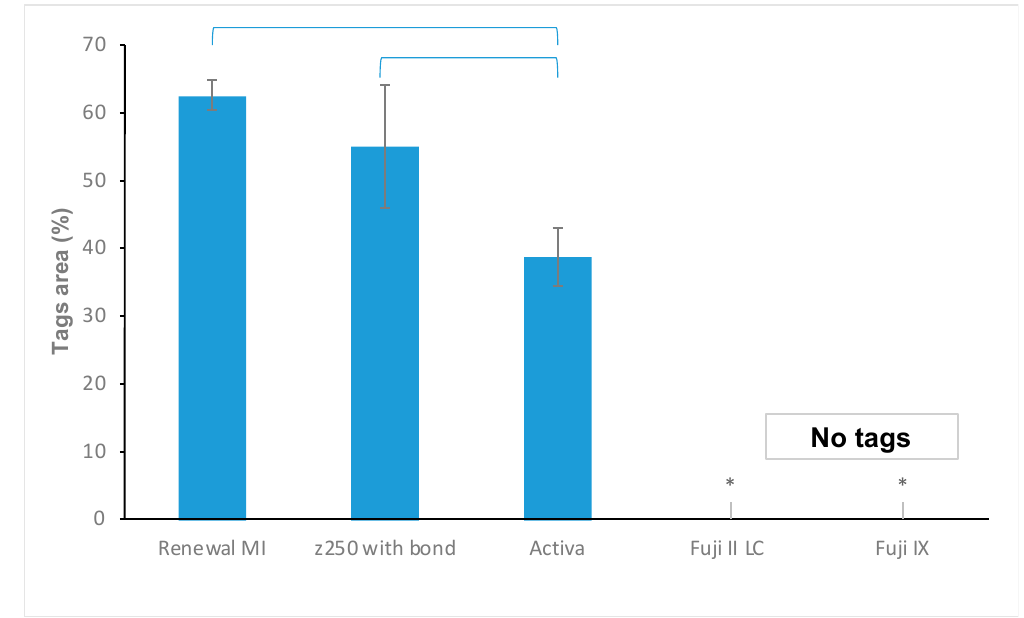
Figure 4. Tag coverage area at the adhesion interface with the demineralized dentine using Renewal MI, Z250, Activa, Fuji IX or Fuji II LC. * indicates a significant difference from all other groups, while the blue bars indicate a significant difference within groups. Error bars are 95% CI ( n = 3).